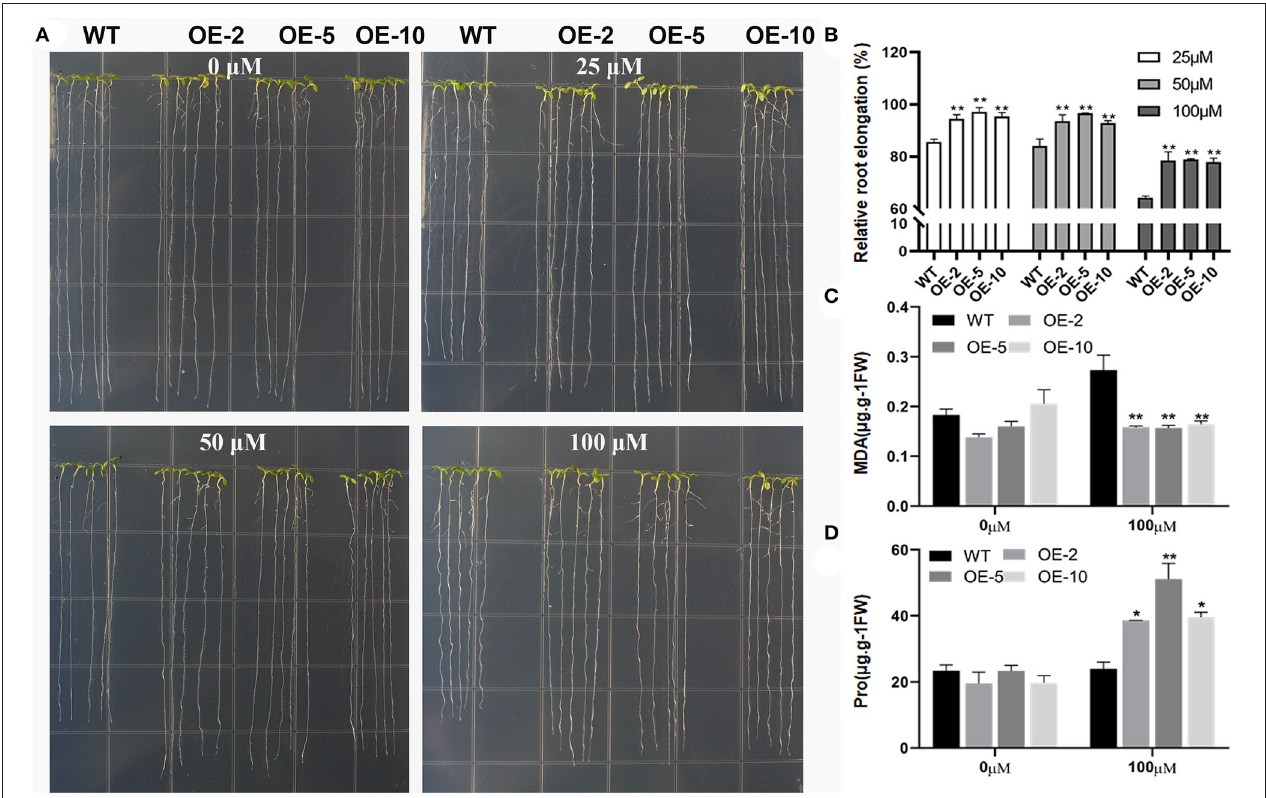
FIGURE 4 | Overexpression of GmWRKY21 conferred enhanced Al tolerance in transgenic Arabidopsis. (A) The phenotypes of GmWRKY21 transgenic lines (OE-2, 5, and 10) and wild type (WT) under different treatments of AlCl 3 solutions. Five-day-old seedlings were transferred to solid agar medium supplied with 1mM CaCl 2 and 1% sucrose containing different concentrations of AlCl 3 (0, 25, 50, or 100 µ M; pH 4.5) for 5 days. (B) The analysis of relative root elongation for the GmWRKY21 transgenic lines and WT. (C) The determination of MDA content. (D) The determination of free proline content. All data are presented as means ± SEM. A significant difference according to the one-way analysis of variance is denoted as follows: * P < 0.05, ** P <